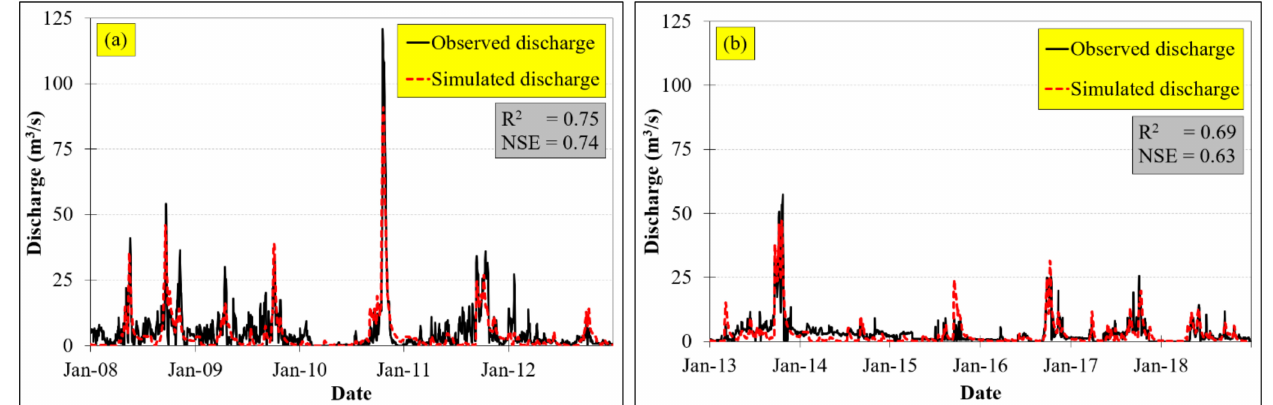
Figure 3. Comparison of observed and simulated daily flows at M.164 gauging station during ( a ) calibration (2008–2012) and ( b ) validation